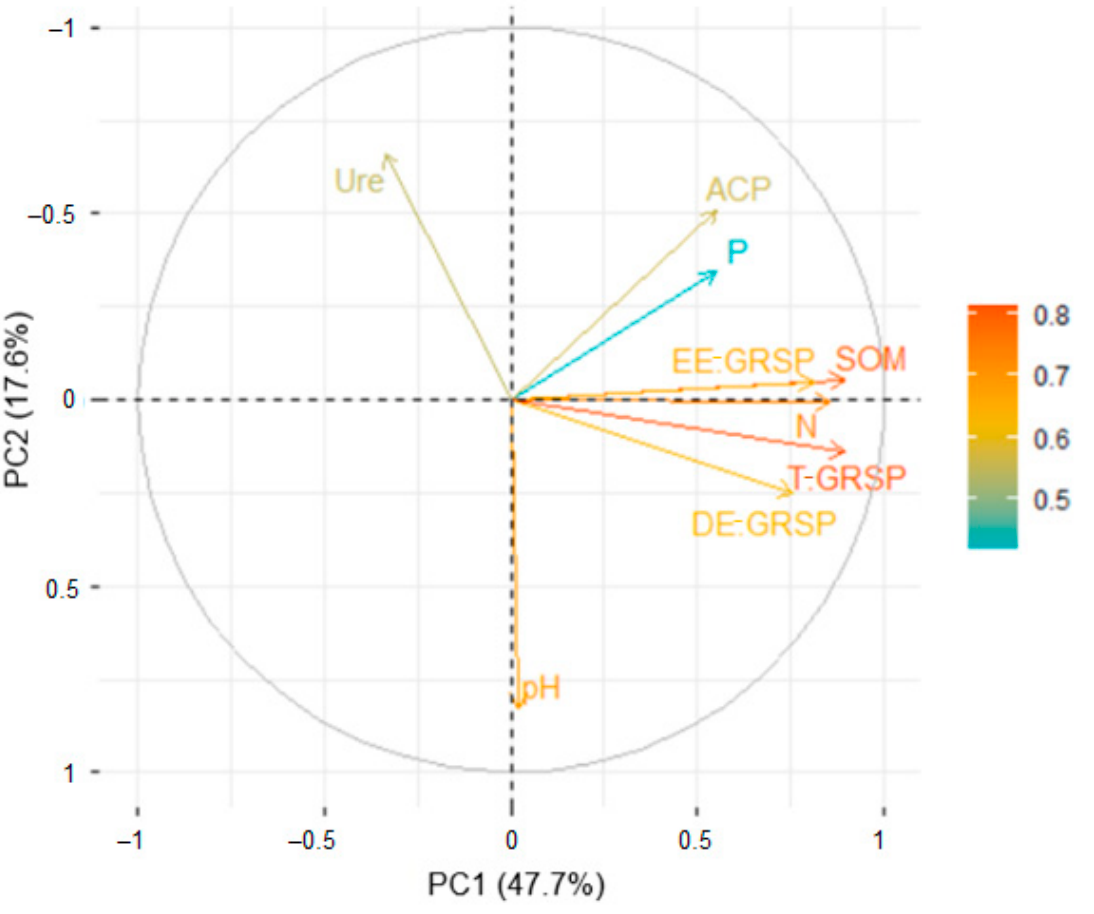
Figure 6. Principal component analysis (PCA) of edaphic factors at the sampling sites. Ure, ACP, SOM, EE-GRSP, DE-GRSP, and T-GRSP represent urease, acid phosphatase, soil organic matter, easily extractable glomalin-related soil protein, difficult-to-extract GRSP, and total GRSP,